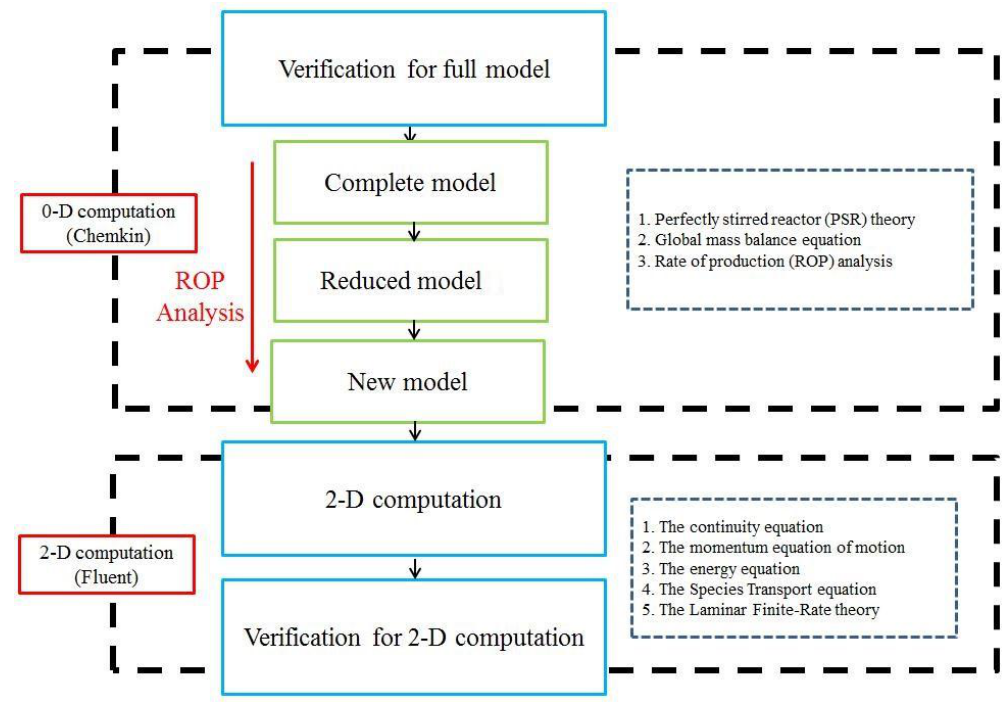
Figure 1. Schematic procedure of the complete numerical modeling.